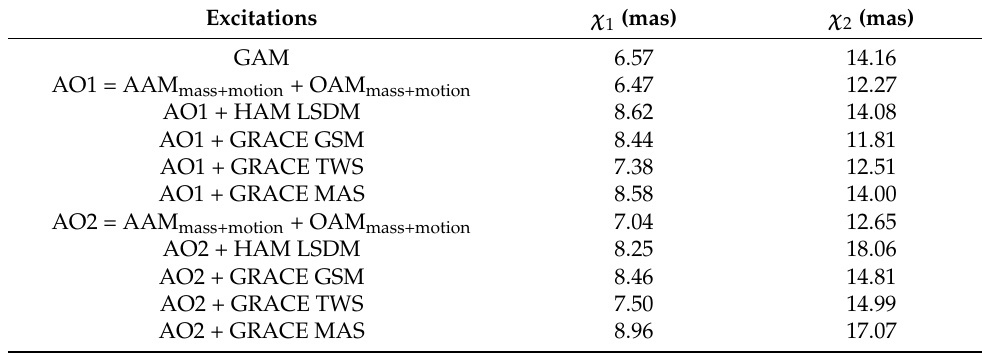
Table 2. RMS of the geodetic and geophysical interannual PM excitations improved by different HAM excitations.